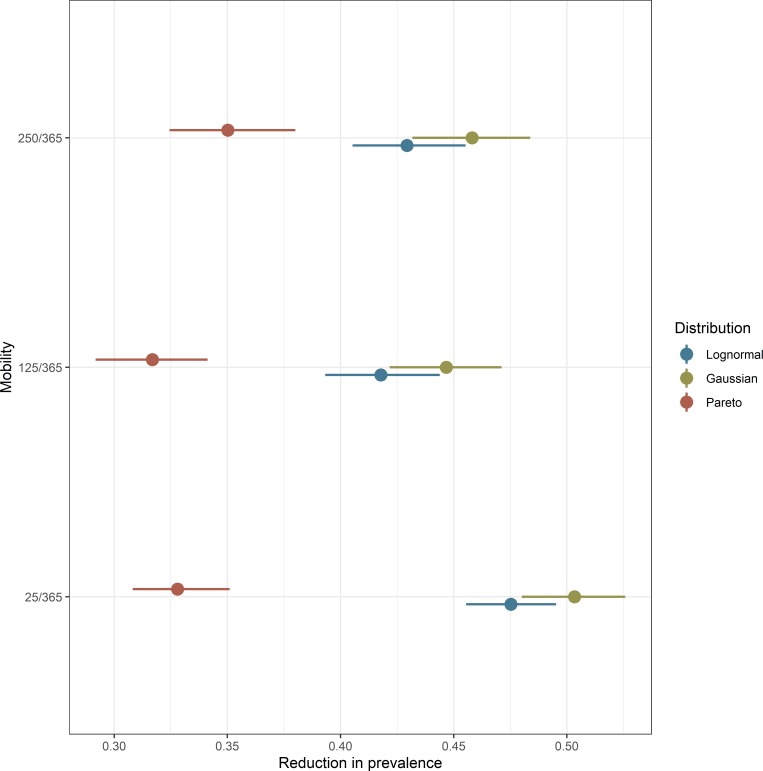
Interplay between population mobility and transmission heterogeneity.Intervention outcome sensitivity to spatial transmission heterogeneity in settings with different population mobility patterns. The vectorial capacity distributions associated with these simulations are displayed in Figure 1D. Points and adjacent lines indicate the median and interquartile ranges (based on 100 simulations for each parameter set).